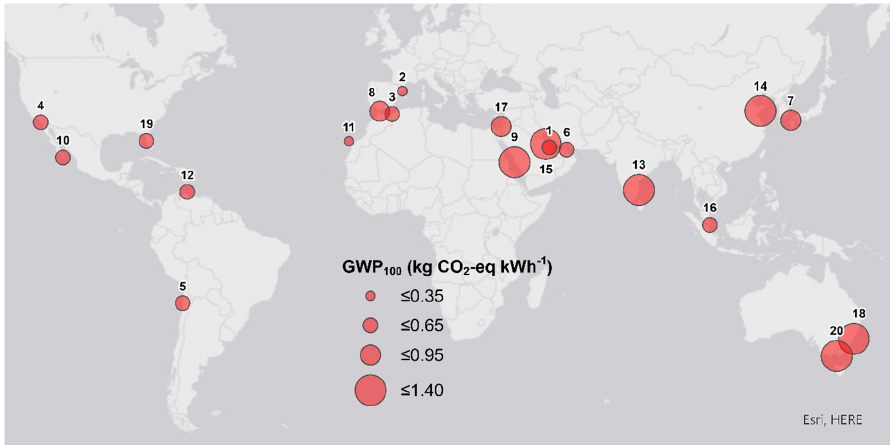
Figure A1. The 100-year Global Warming Potential of the electricity mix. Impact assessment method: IPCC 2013. Dataset: market for electricity, medium voltage, Allocation, cut-off by classification. Geography: Table A1. Database: ecoinvent version 3.6. Data from ecoinvent [65].